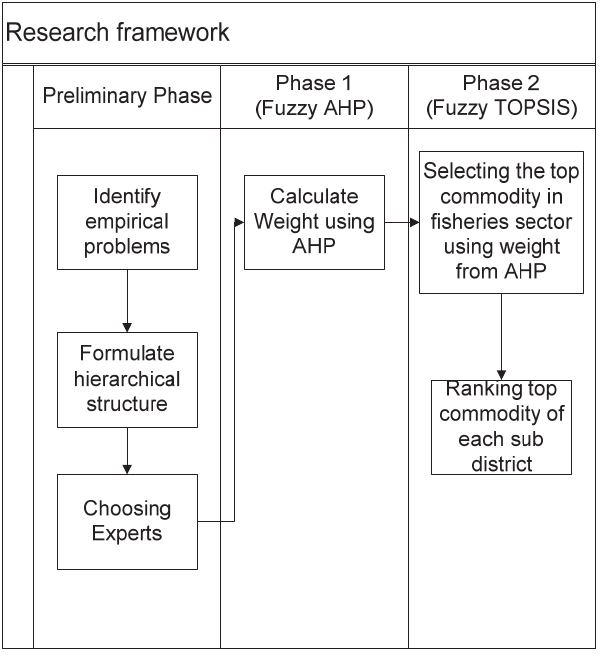
Fig. 2. Proposed research